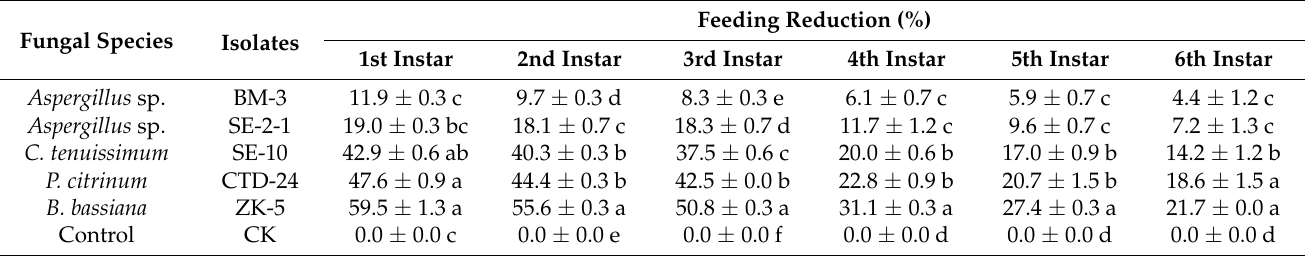
Table 8. Effects of fungal isolates on feeding performance of sixth instar S. frugiperda larvae at 1 × 10 7 conidia mL − 1 . Feeding Reduction (%) Fungal Species Isolates 1st Instar 2nd Instar 3rd Instar 4th Instar 5th Instar 6th Instar Aspergillus sp. BM-3 21.4 ± 0.0 c Aspergillus sp.